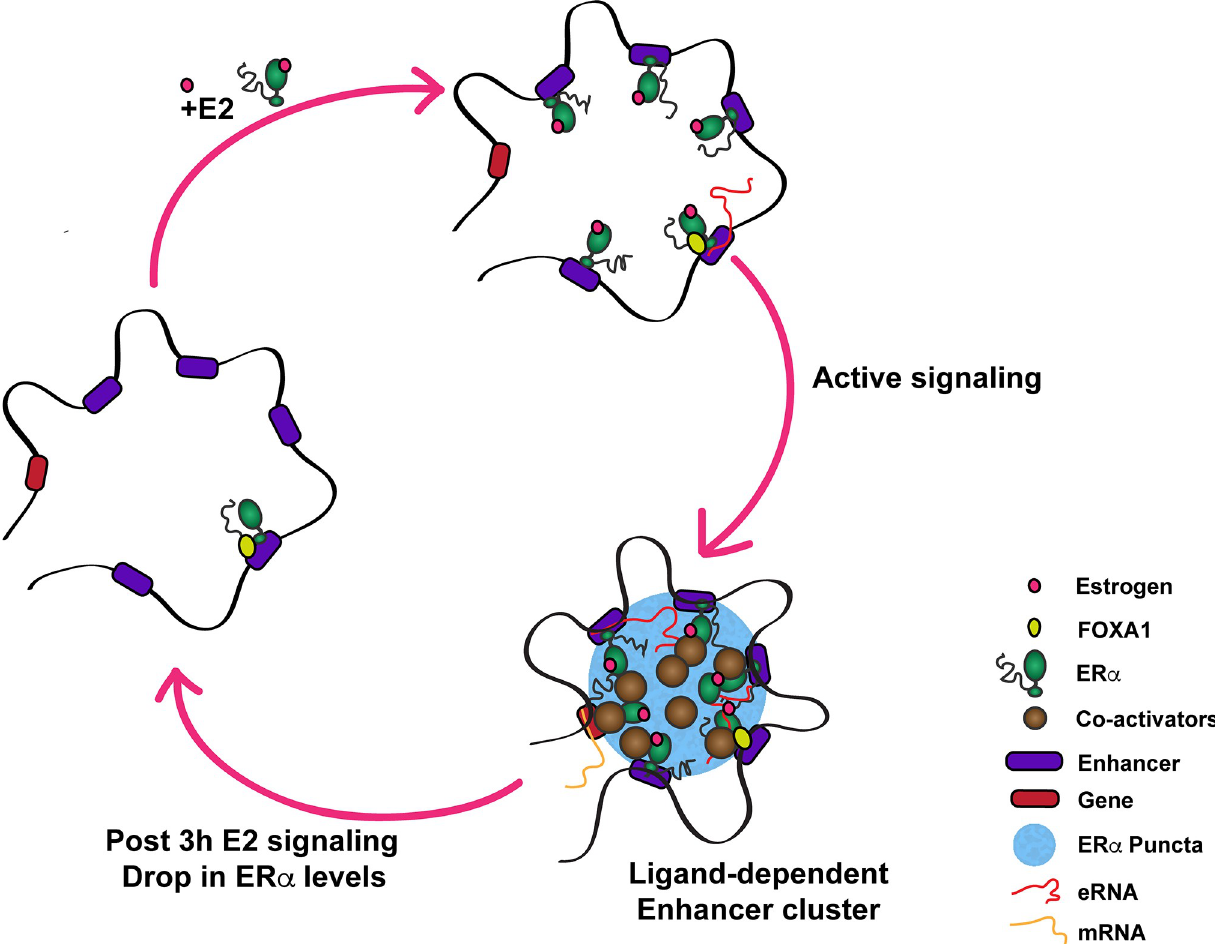
Fig 8. Proposed Model of E2-mediated transcriptional regulation. Model depicts the active and inactive phases of estrogen signaling. During active phase, liganded ER α decorates the EREs closer to premarked-unliganded ER α site. Together, these persistent and transient sites form LDEC in 3D manifesting as ER α puncta, resulting in robust expression of target genes. Upon ER α degradation at 3h or upon deletion of persistent site, these clusters disappear leaving persistent site behind still bound by ER α as bookmark, for next round of ligand stimulation.